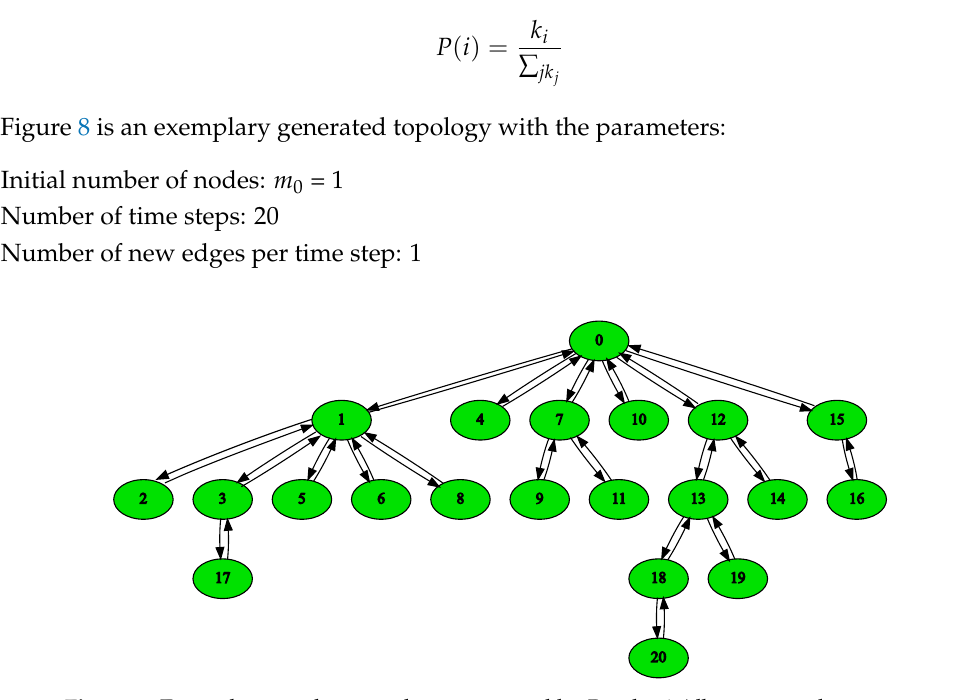
Figure 8. Exemplary random topology generated by Barabasi Albert network